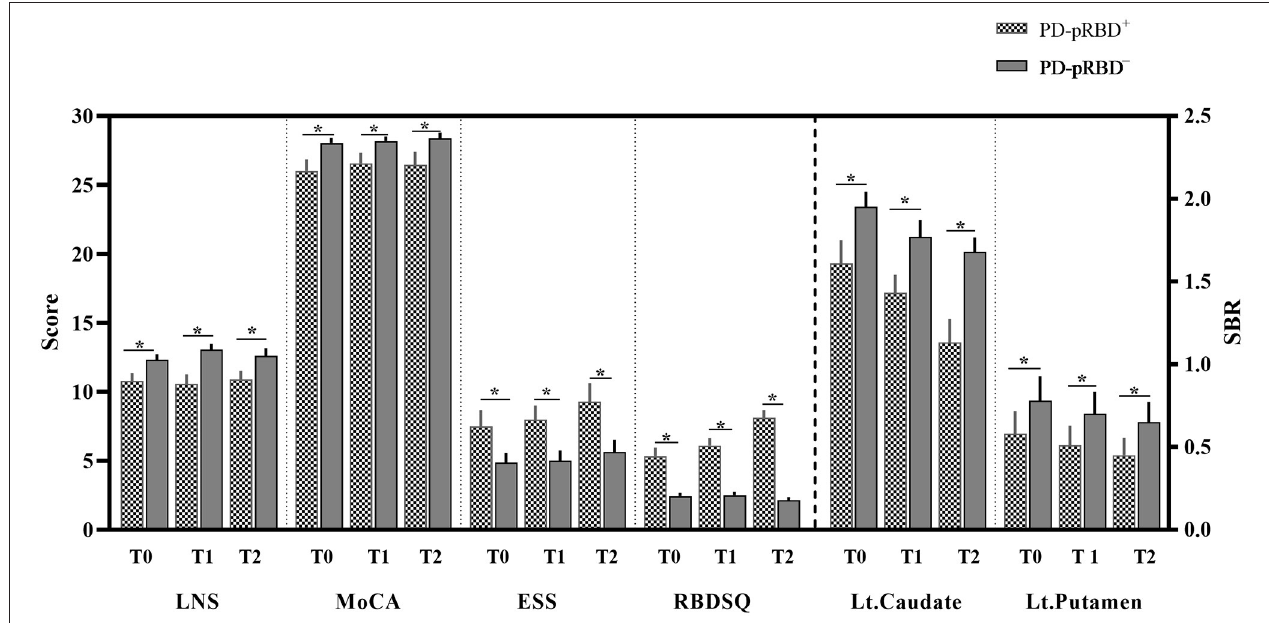
FIGURE 2 | Significantly different neuropsychological assessments between-group comparisons. PD-pRBD + , Parkinson’s disease (PD) with probable rapid eye movement (REM) sleep behavior disorder (pRBD); PD-pRBD − , PD without pRBD; T0, fMRI data at onset; T1, the 1-year follow-up evaluation; T2, the 3-year follow-up evaluation; LNS, letter-number sequencing; MoCA, Montreal cognitive assessment; ESS, Epworth sleepiness scale; RBDSQ, RBD screening questionnaire; SBR, striatal binding ratio; Lt, left; *, showed significant differences between patients with PD-pRBD + and PD-pRBD − .